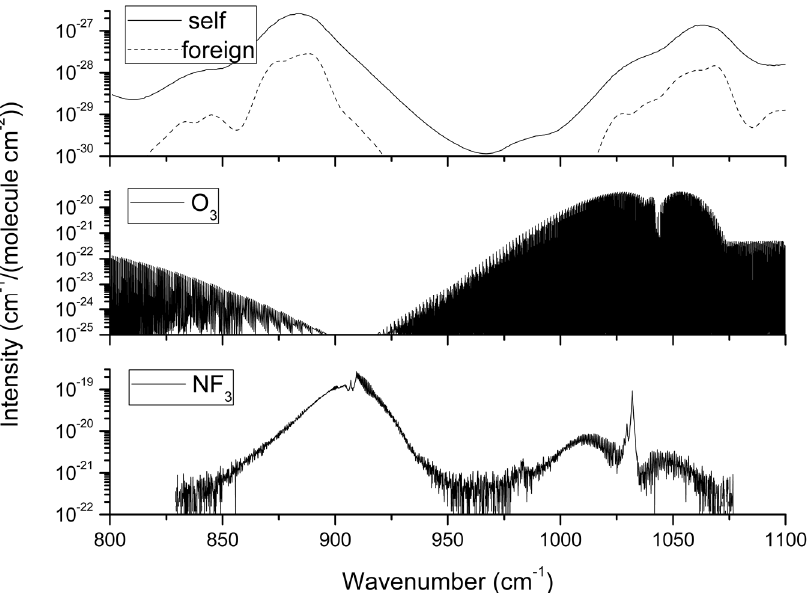
Figure 2. H 2 O self and foreign continuum, O 3 , and NF 3 absorption intensity between 800 cm − 1 and 1100 cm − 1 .